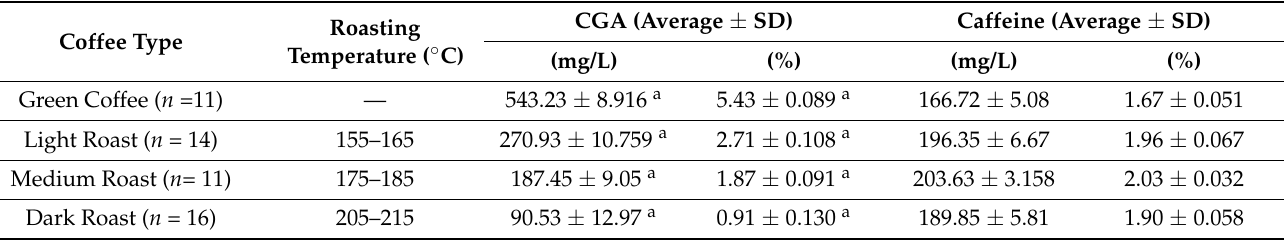
Table 1. The average concentration (mg/L) for caffeine and chlorogenic acid (CGA) content in coffee beans ( n = 52) with different roasting degrees, regardless of geographical origin.